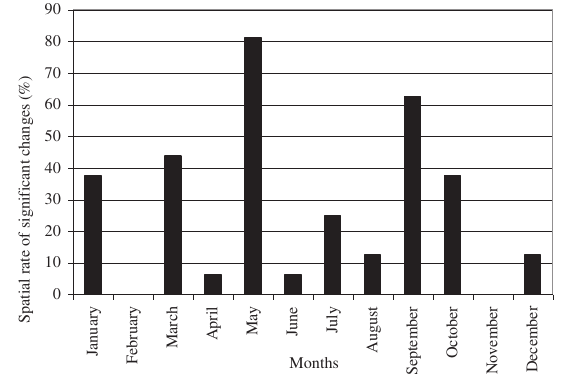
Figure 9 – The temporal distribution of changes of absolute minimum temperatures measured at the 16 stations, where the signifi cance was generally on the 95% level for the period of 1951–2010